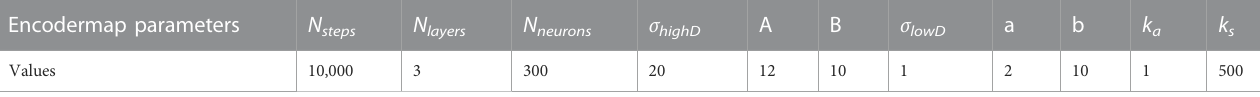
TABLE 1 Encodermap parameters used to generate the 2D projection shown in this work. Encodermap